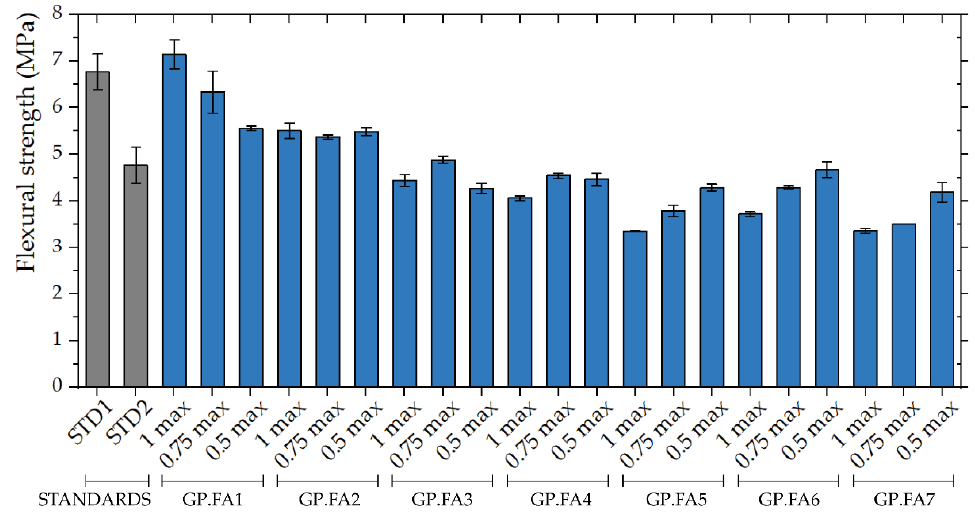
Figure 3. The flexural strength of the geopolymers synthesized with fly ash from thermal power